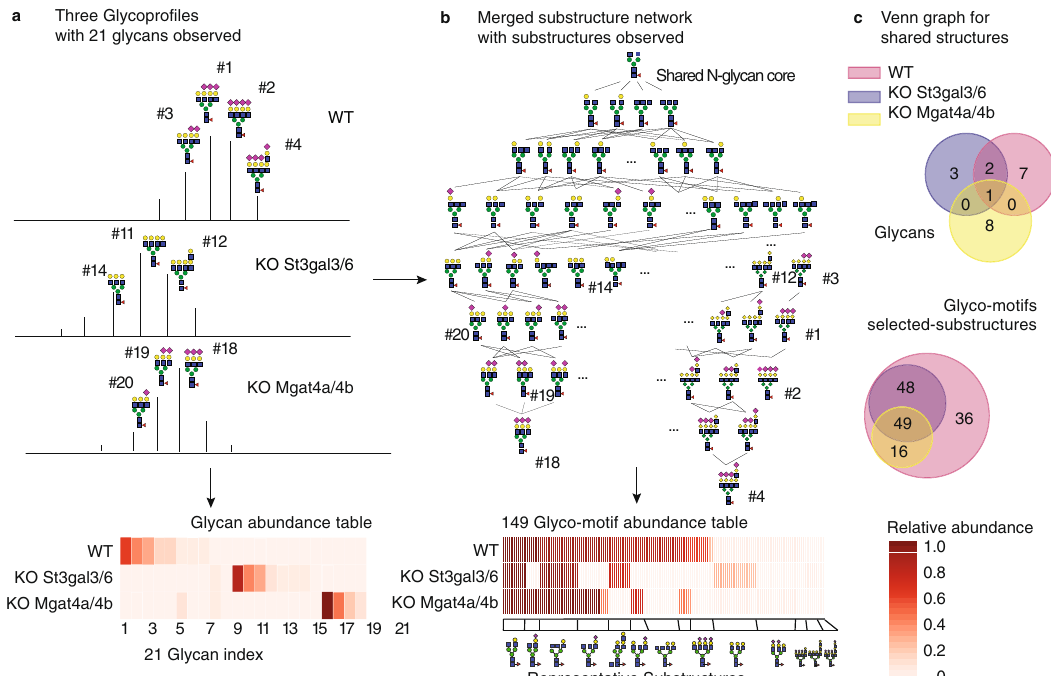
Fig. 1 The GlyCompare platform improves glycomics data analysis and interpretation by using glycan biosynthetic network data to account for glycan interdependence. a Three example glycopro fi les (WT, Mgat4a/4b knockout, and St3gal4/6 knockout pro fi les), with annotated glycans and measured relative glycan abundances, show low overlap despite differing in only a few gene knockouts. b The low overlap can be rescued by propagating glycan substructures through the glycan biosynthetic network. Then, the glycopro fi le is transformed into glyco-motif vectors. The representative substructure is generated to represent core glycan substructures of glycopro fi les (see “ Methods ” ). c Venn diagrams show the imperfect overlap of glycans across samples (upper), which is rescued when using GlyCompare to analyze glyco-motif substructures (bottom). Source data are provided as a Source data fi